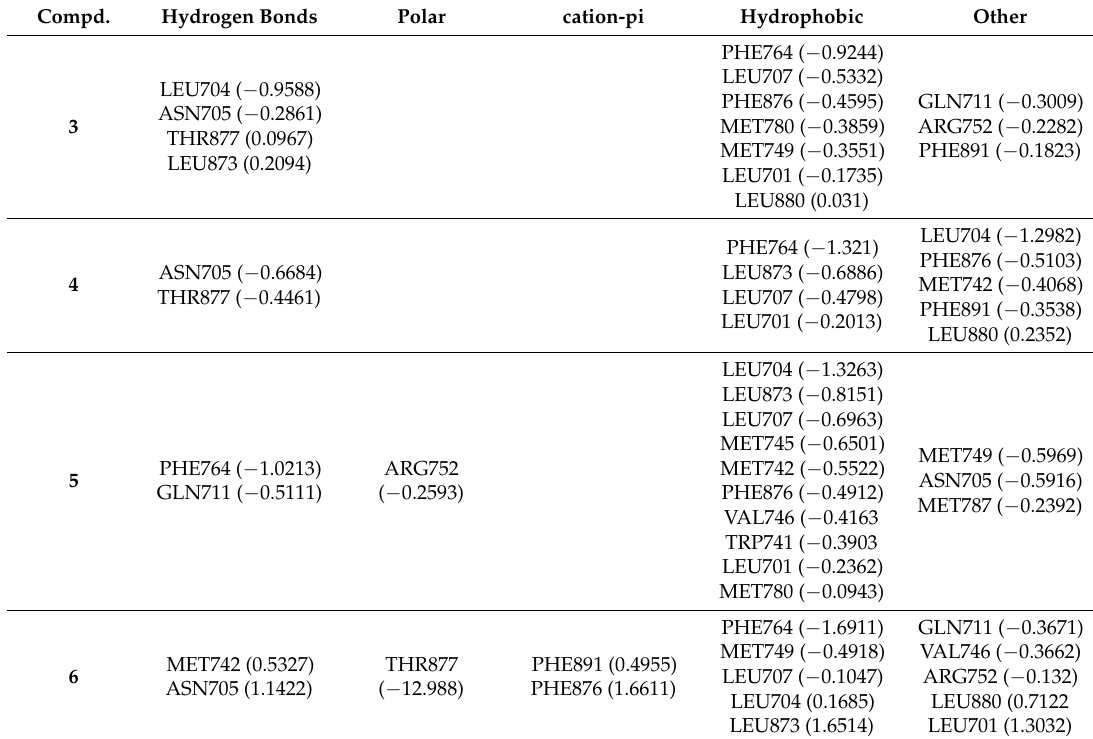
Table 4. Decomposed energy of some synthesized compounds with prostate cancer receptor (2q7k).